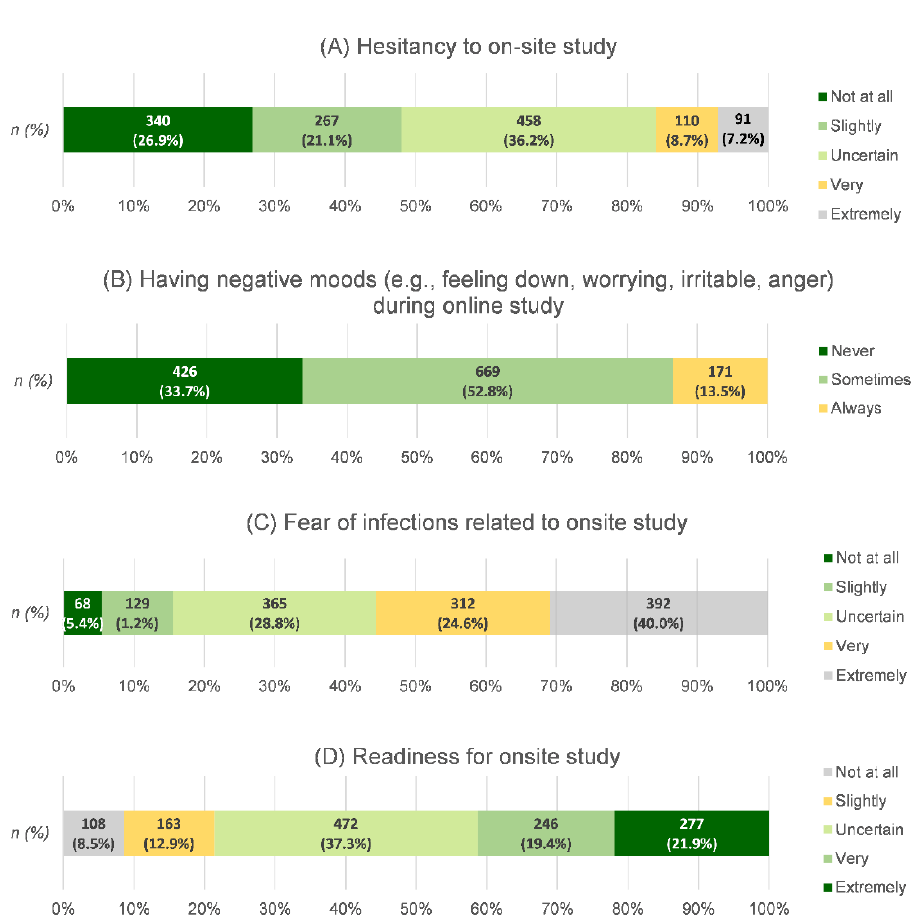
Figure 6. Students’ hesitancy, negative moods during online study, and attitudes toward on-site studying.